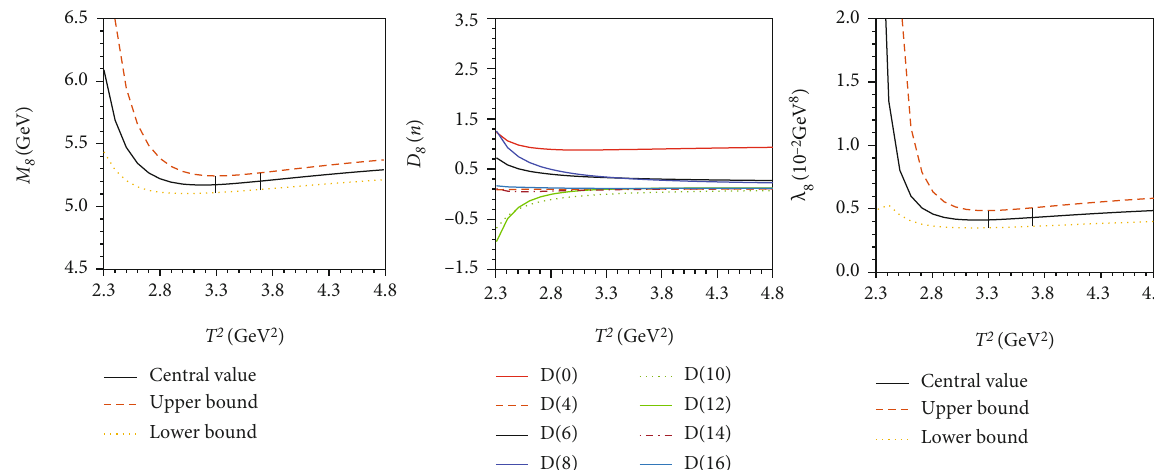
− T 2 for (a), dashed curve is drawn from the upper values of the input parameters and dotted : M 8 8 ð n Þ − T 2 for (b); λ − T 2 for (c), dashed curve is drawn from the upper values of the input parameters 8 8